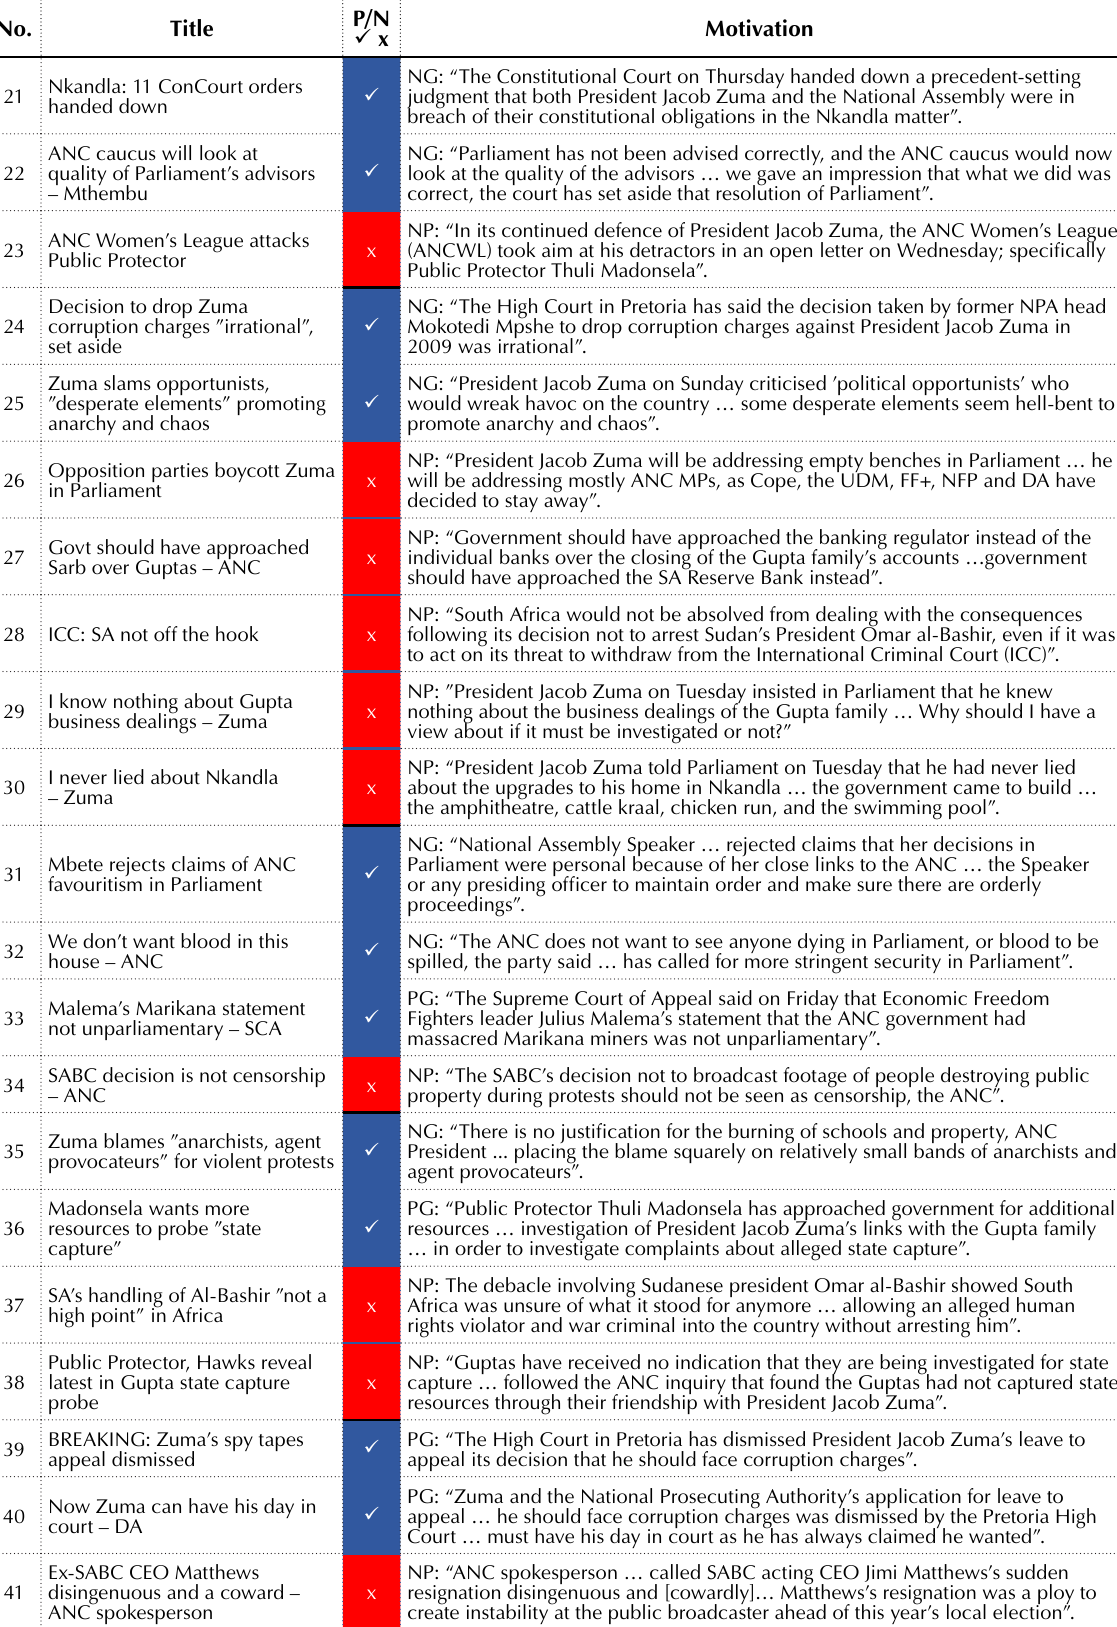
Table 5A (cont.). Institutional macro-environment (January-June 2016)